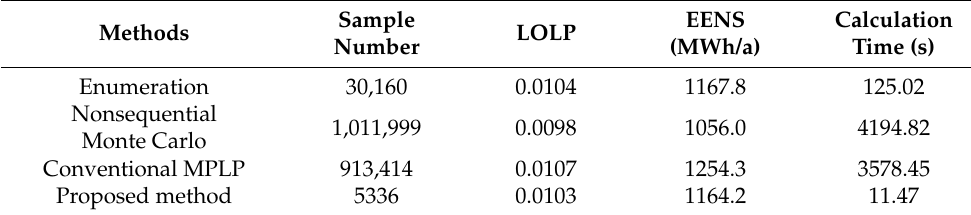
Table 1. Reliability assessment results of the